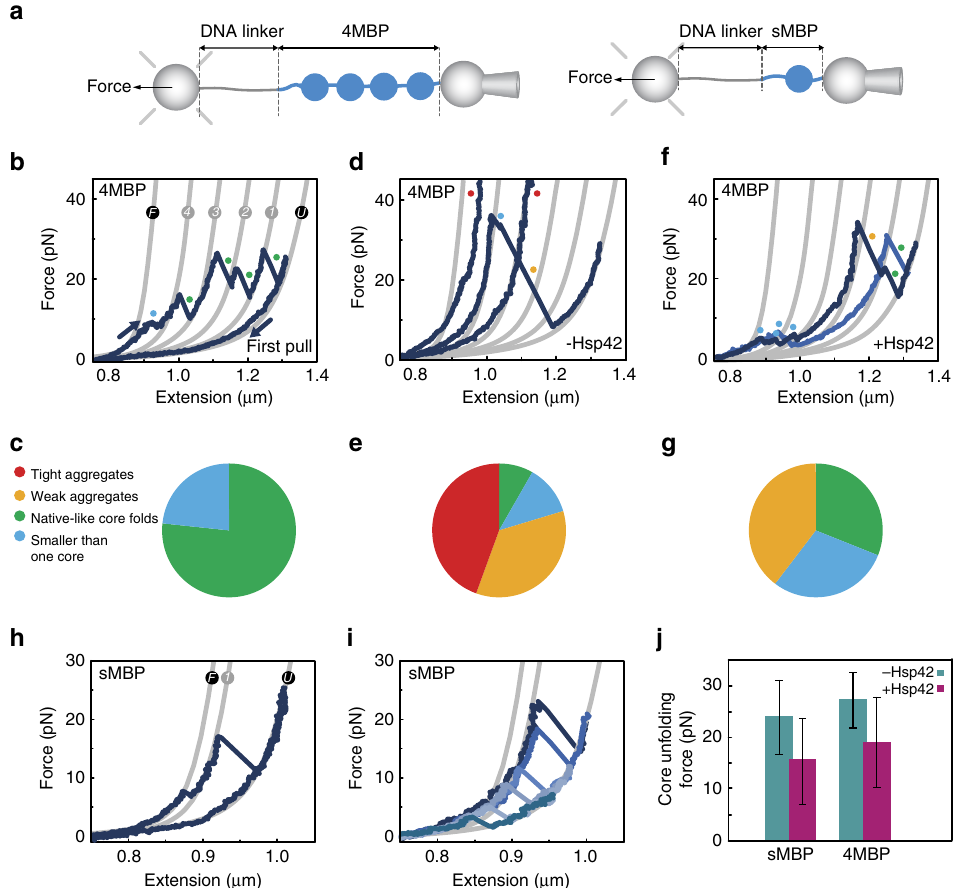
Figure 1 | Effect of Hsp42 at the single-molecule level. ( a ) Schematic diagram of the setup; MBP constructs are tethered by means of a DNA handle between two beads: one held on a position-controlled micropipette, another by an optical trap that allows force detection. ( b ) First stretching–relaxation curve, showing the unfolding pattern of natively folded 4MBP. Grey lines represent the theoretical WLC characterizing the DNA-4MBP construct from fully folded (F) to the fully unfolded (U) state. After C-terminal unfolding (F - 4) in all four MBP repeats, four core unfolding events (4 - 3 - 2 - 1 - U) are observed. Coloured points indicate the type of observed protein structures (Supplementary Fig. 1). The category ‘smaller than one core’ includes gradual transitions, as seen here for F - 4. ( c ) Corresponding fractions of the types of observed structures ( N ¼ 20). Fractions are normalized by the length of the amino acid chains that form the structure. ( d ) Second or subsequent stretching curves after relaxation and waiting at zero force for 5s without chaperone. ( e ) Corresponding fractions of the types of observed structures ( N ¼ 30). ( f ) Second or subsequent stretching curves in the presence of Hsp42 (5 m M). ( g ) Corresponding fractions of the types of observed structures ( N ¼ 30). ( h ) Stretching curves for sMBP. Grey lines represent WLC model for DNA-sMBP for the fully folded (F), the single core (1) and fully unfolded (U) states. ( i ) Stretching curves in the presence of Hsp42 (5 m M). ( j ) Corresponding core unfolding forces ( N ¼ 51 and N ¼ 42 for sMBP and 4MBP